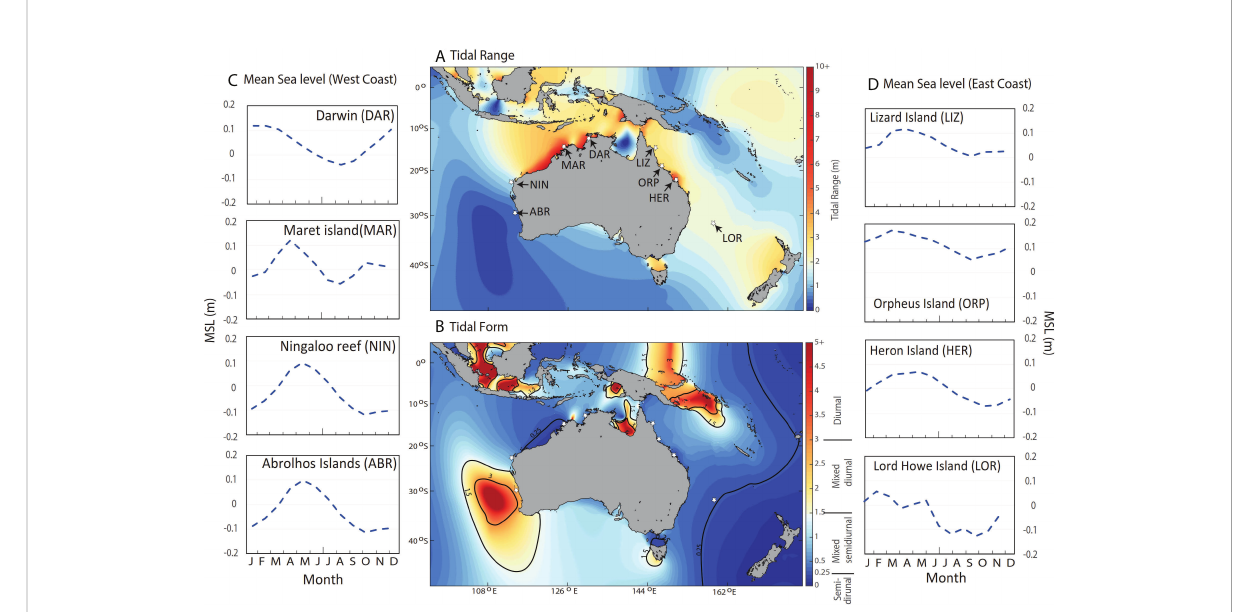
FIGURE 1 Study sites in relation to (A) tidal range (difference between highest and lowest astronomical tidal heights in meters) and (B) tidal form, (ratio of major diurnal to semi-diurnal tidal constituents) and mean sea level (MSL) (1992 – 2016) for (C) West Coast and (D) East Coast study sites. Tidal characteristics for A and B were obtained from the ozROMS model (Wijeratne et al.,